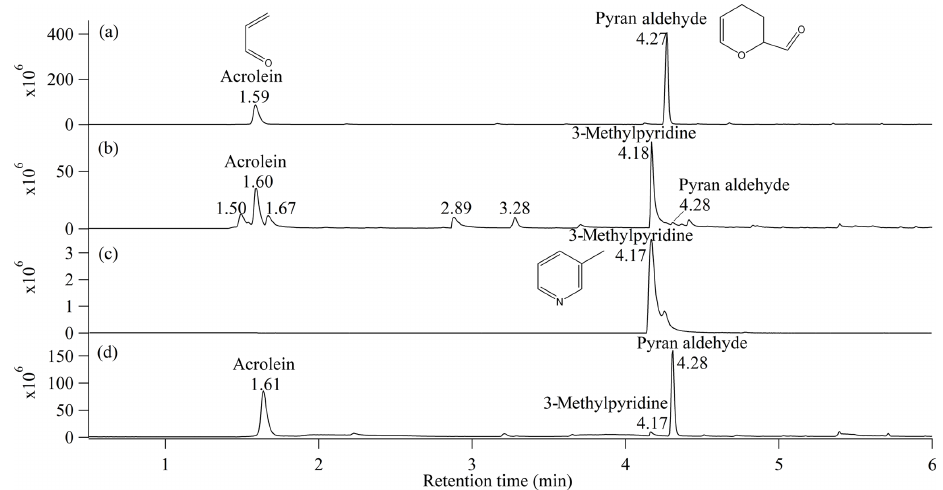
Figure 1. GC traces for: (a) the gaseous components in the control experiment with acrolein only; (b) the gaseous components in the acrolein- ammonia bag; (c) standard 3-methylpyridine; (d) the gaseous components in the acrolein-ammonium bag using (NH 4 ) 2 SO 4 . The retention times and important compounds identified by NIST library are labeled. The GC-MS results for the acrolein-ammonium experiment using NH 4 Cl produced results that were very similar to (d) , so they are not included here. The corresponding MS patterns for the main peaks are shown in Fig. S2.